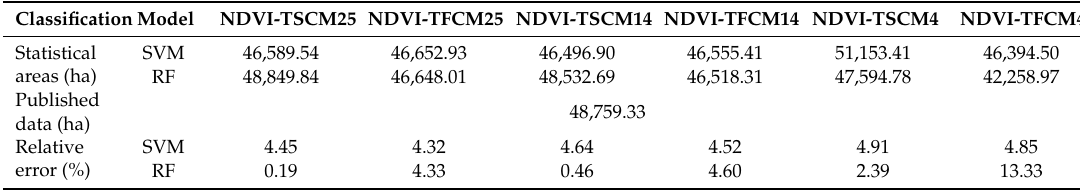
Table 7. Quantitative evaluation of wheat statistical